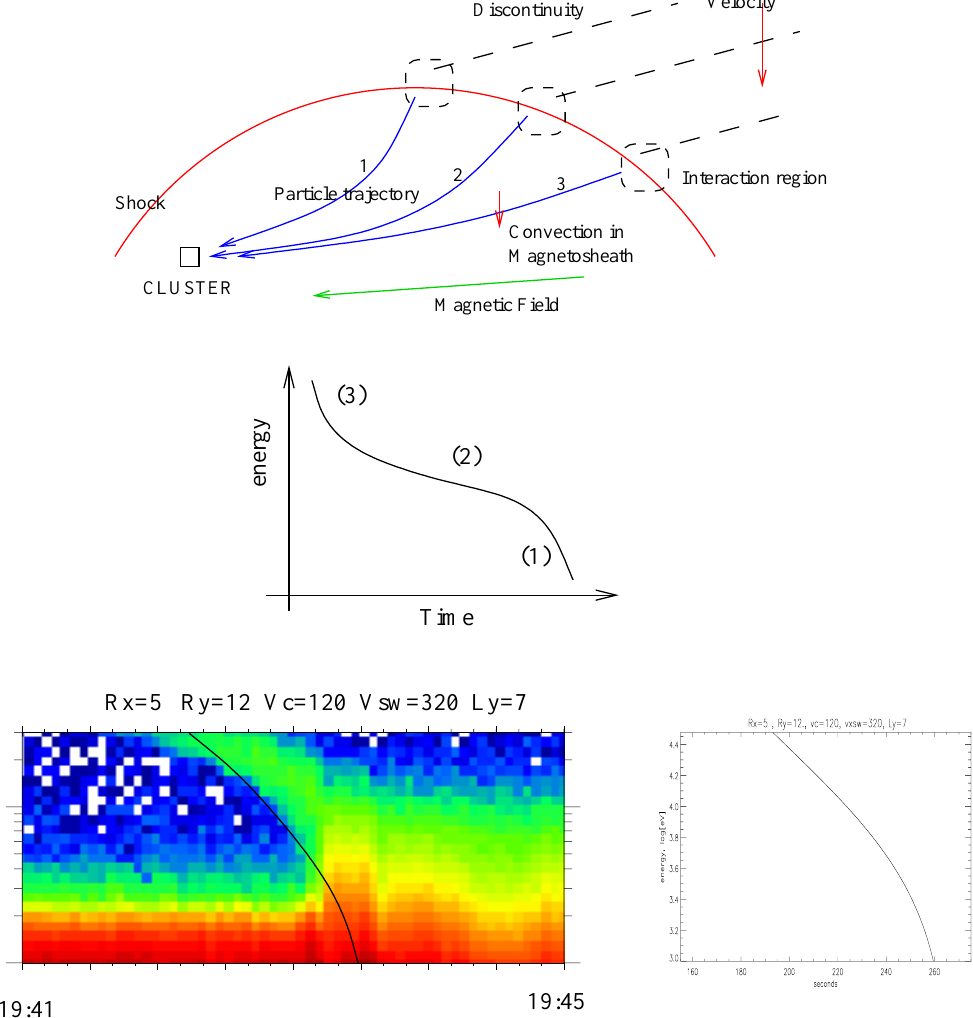
Fig. 4. The cinematic model of the interaction. From top to bottom: (1) global configuration of the interaction and examples of trajectories, (2) typical dispersion calculated from the model and, (3) fit of the